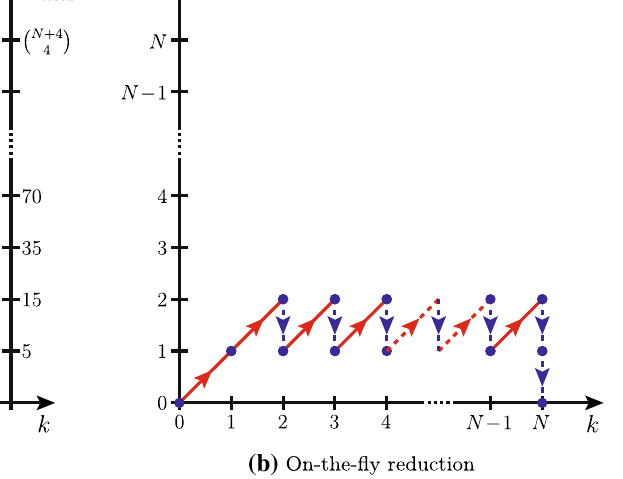
nal open-loop algorithm, where tensor reduction is applied a posteriori (left), is compared to the on-the-fly reduction approach (right). The red diagonal lines illustrate the dressing steps and the blue vertical lines the reduction